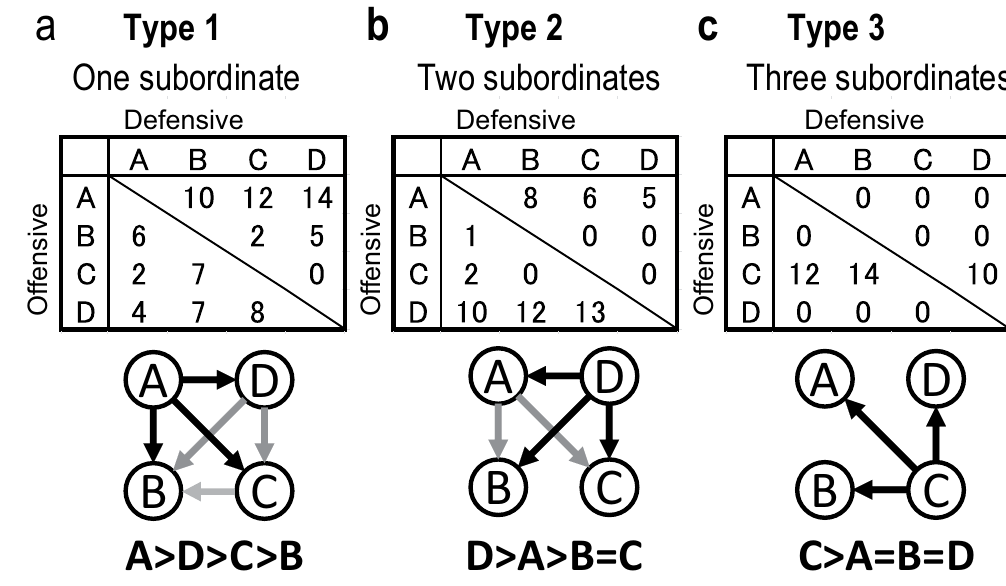
Figure 1. Determination of the social hierarchy in a group-housing cage. The social hierarchy in a home cage was determined from the home-cage dyadic agonistic interactions. The mouse that exhibited offensive behaviour and elicited submissiveness from all other mice was designated the dominant mouse. Mice that exhibited submissive behaviour to other mice but never dominated another cage mate were designated subordinate. ( a ) Type 1: a linear hierarchy was estimated when the relationships between individuals were transitive (i.e., if mouse A dominated mice B, C and D, mouse D dominated mice B and C, and mouse C dominated mouse B). In this manner, the dominant and subordinate males were defined as the individuals with the highest and lowest ranking, respectively, and the mice intermediate between the dominant and subordinate males were considered to be intermediate males. ( b ) Type 2: two subordinates were identified when no agonistic interactions were observed between the two lowest ranking mice. ( c ) Type 3: a case with one dominant and three subordinate